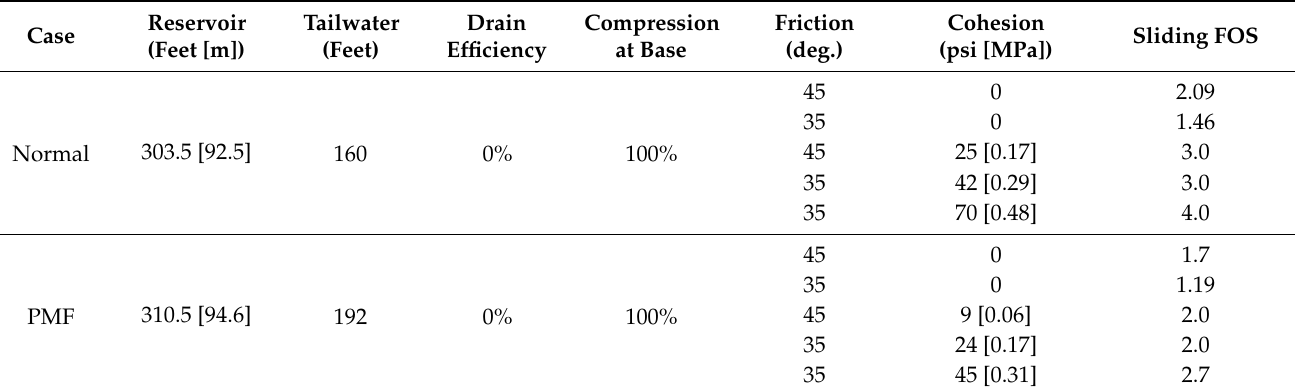
Summary of static gravity analyses for increased uplift and reduced contact strength